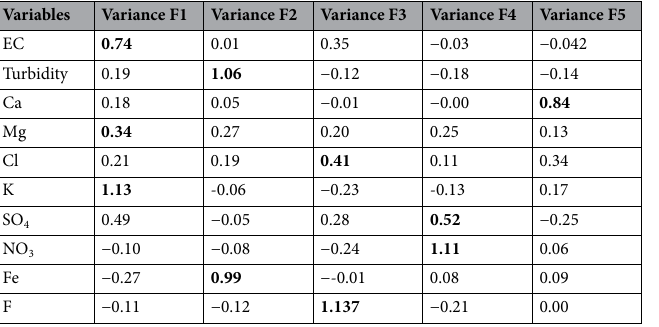
Table 6. Loadings matrix in rotated coordinates system. The variables EC, Mg and K are in the column Variance F1, and they display the highest magnitude in their respective rows in comparison to Variance F2, Variance F3, Variance F4 and Variance F5. These values are highlighted to indicate that EC, Mg and K are explained by 1st factor. Similarly, Turbidity and Fe are explained by 2nd factor (in column Variance F2); Cl and F are explained by 3rd factor (in column Variance F3); SO 4 and NO 3 are explained by 4th factor (in column Variance F4), and Ca is explained by 5th factor (in column Variance F5).